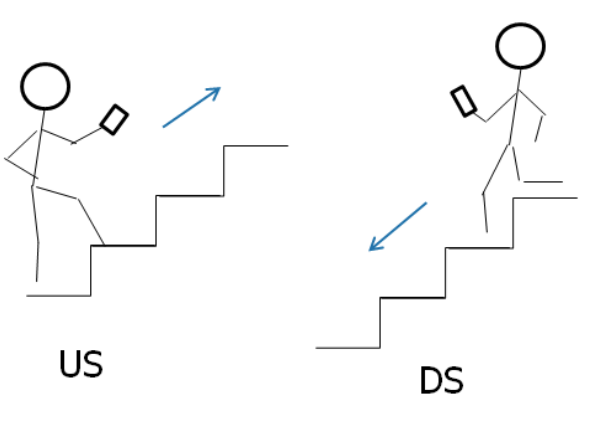
Figure 4. V-series (left: US and right: